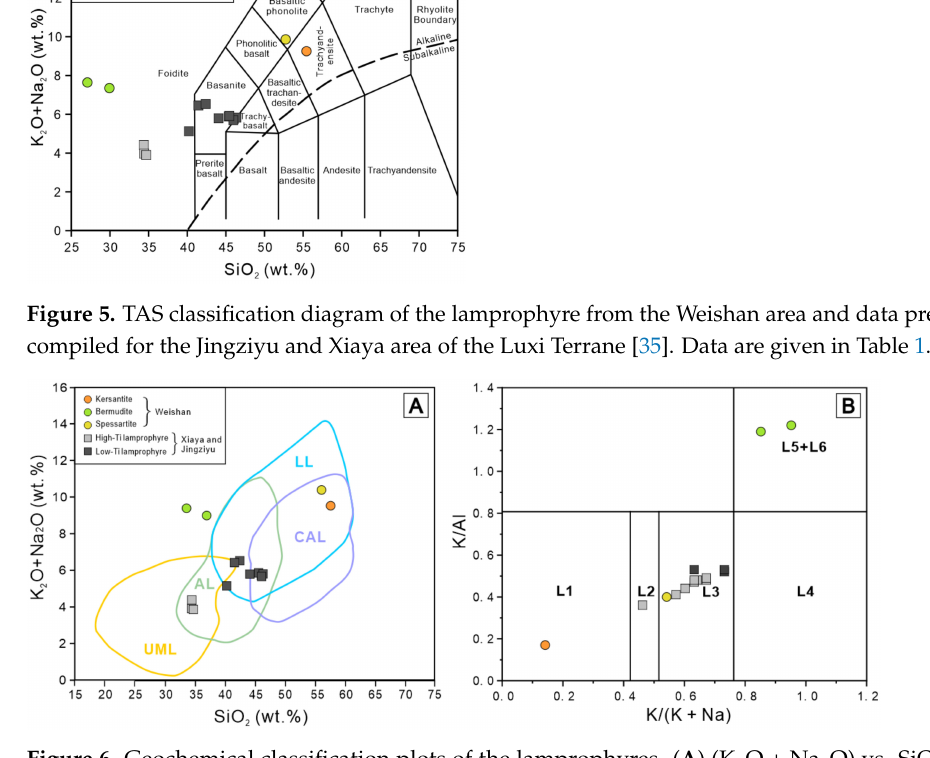
Figure 6. Geochemical classification plots of the lamprophyres. ( A ) (K 2 O + Na 2 O) vs. SiO 2 classi- fication diagram [1]. ( B ) K/Al vs. K/(K + Na) diagram [36]. Data are given in Table 1.